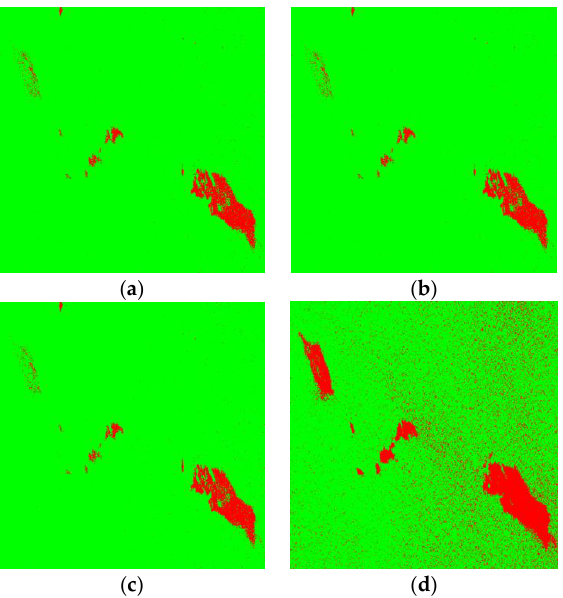
Figure 7. Classification result using SVM based on the features of: ( a ) DP mode; ( b ) π/4 mode; ( c ) π/2 mode; ( d ) S 2 . VV Table 11. Confusion matrix achieved by SVM based on S 2